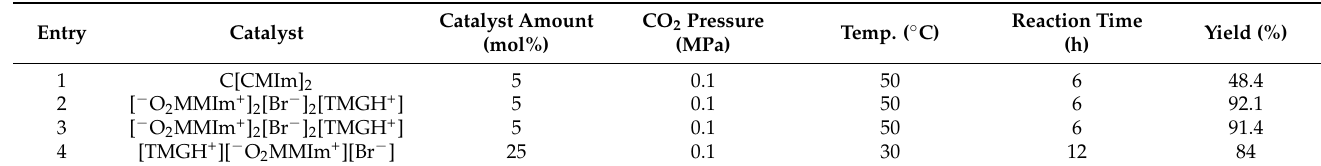
Table 24. Catalytic activity of multifunctional IM-based ILs on the synthesis of CPC by carbonation of EPIC [100,101].